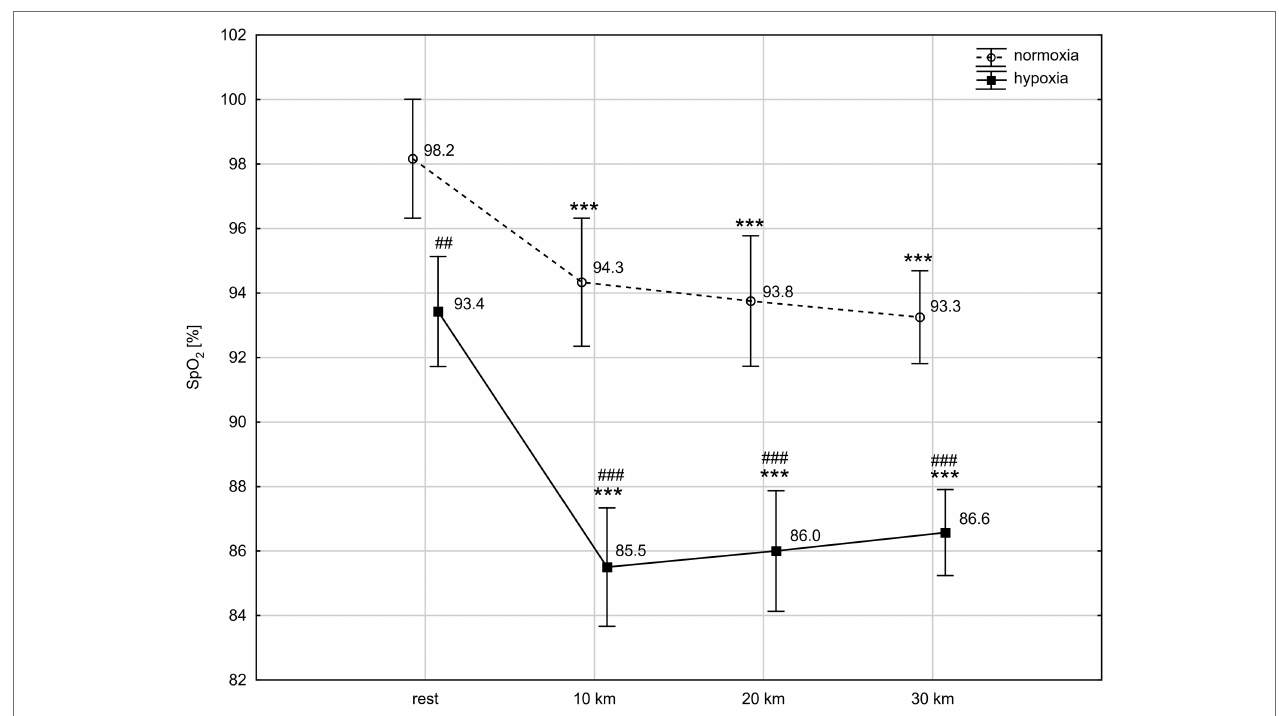
FIGURE 1 | Blood oxygen saturation (SpO 2 ) levels at rest and during 30 km time trial in normoxia and hypoxia. All values shown as mean ± SD; *** p < 0.001 – significant differences between rest and 10 km, 20 km, and 30 km time trial in the same conditions; ## p < 0.01, ### p < 0.001 – significant differences between N and H at the same measuring